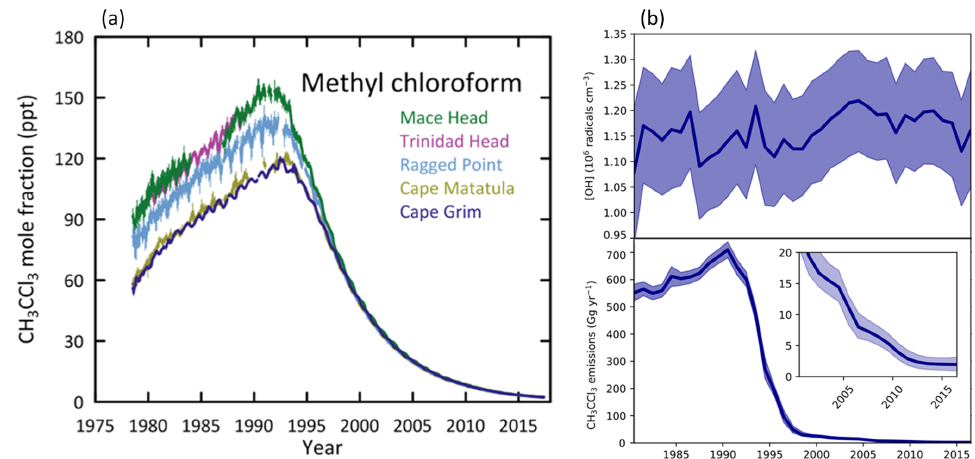
Figure 8. CH 3 CCl 3 monthly mean mole fractions and 1 σ standard deviations at selected AGAGE stations (a) . Global 12-month running mean OH concentrations and CH 3 CCl 3 emissions from the AGAGE data and AGAGE 2-D model inversion. Shaded areas give 1 σ uncer- tainty (b) (Rigby et al., 2017; updated